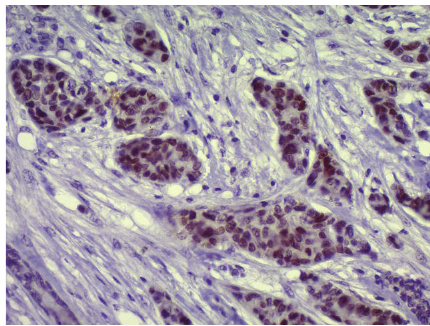
Figure 4: GATA3 nuclear expression in neoplastic cells (GATA3 immunostaining × 200) confirming the breast origin of the parotid